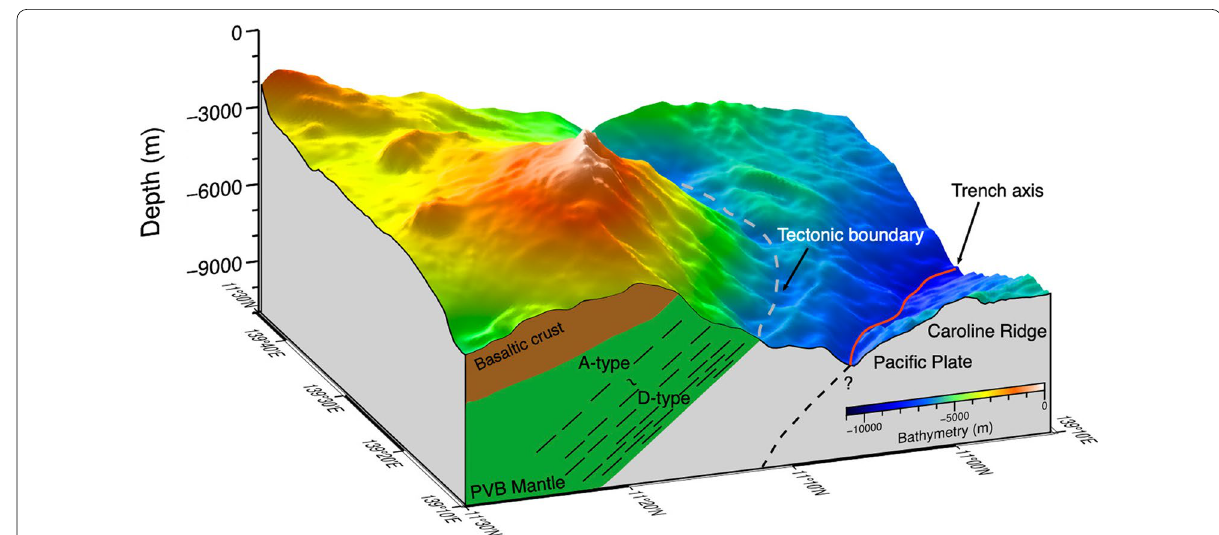
Fig. 11 Schematic bathymetry with a presumed cross section of the 139°E